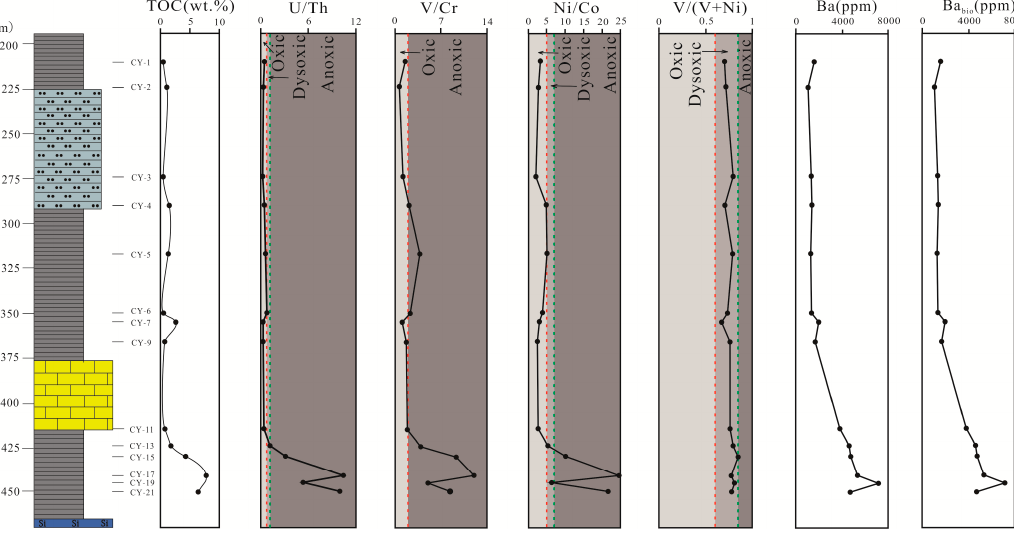
Figure 14. Stratigraphic profiles of CY-1 for TOC, U/Th, V/Cr, Ni/Co, V/(V + Ni), Ba, and Ba bio . The thresholds of V / (V + Ni) (0.6,0.85) are referred from [37]; Redox thresholds of U / Th (0.75,1.25), V / Cr (2.0), and Ni / Co (5.0,7.0) are referred from